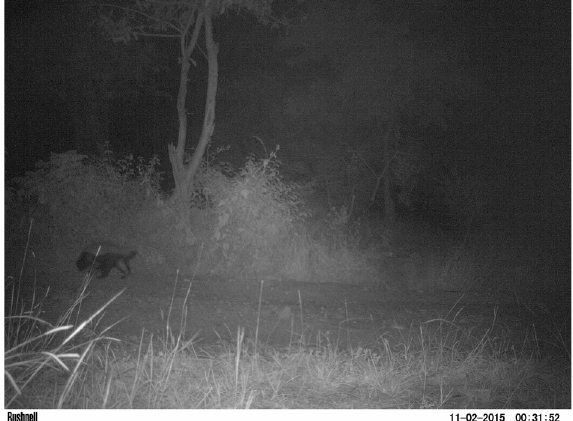
Image 1. Photographic record of a Ratel captured on a camera trap in